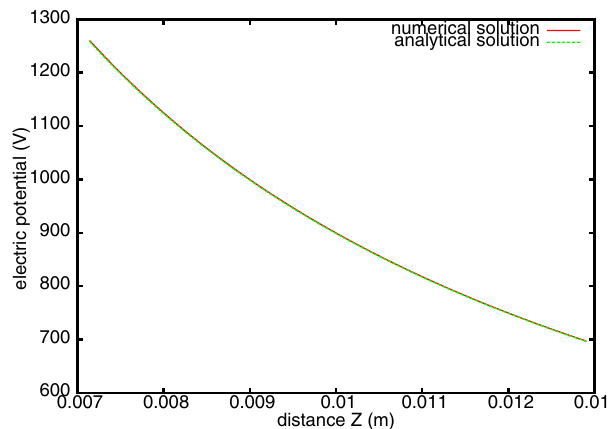
FIG. 1. (Color) A schematic plot of an electron bunch in front of the conducting photocathode together with its image charge.